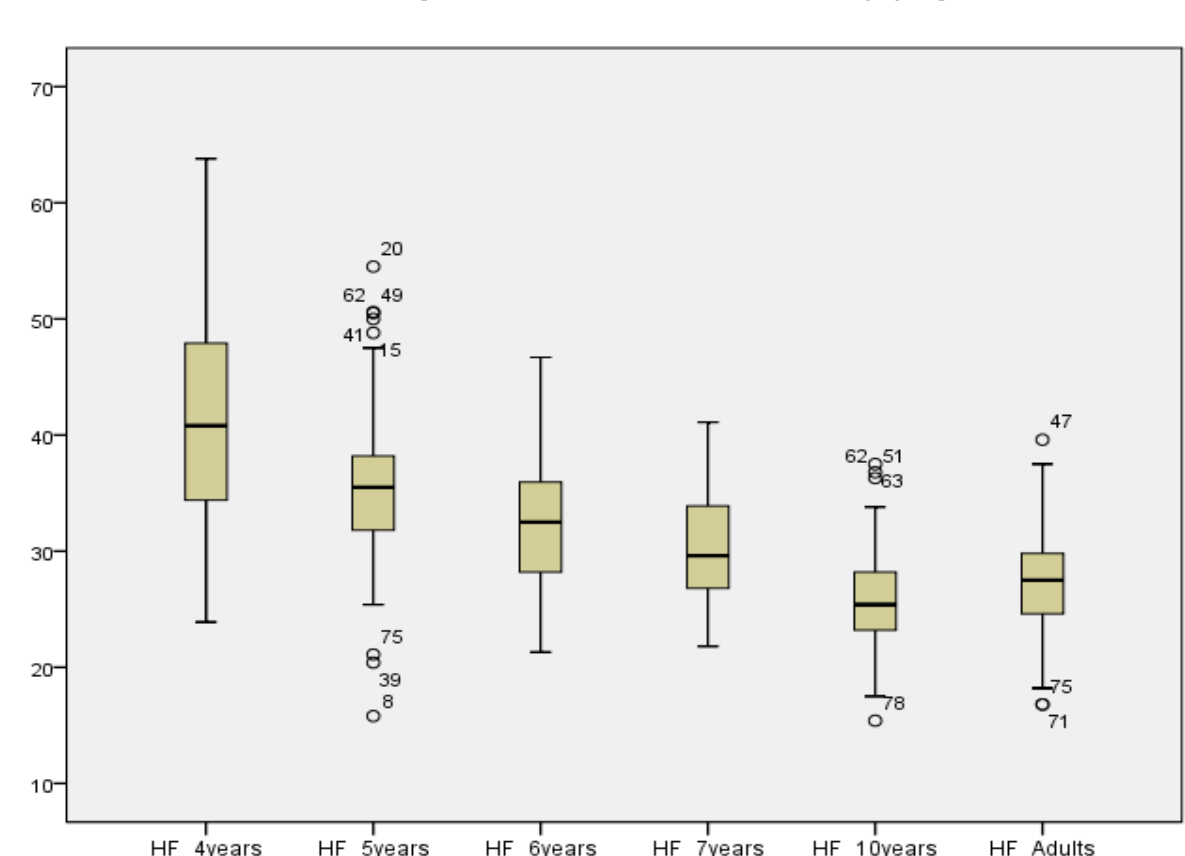
Figure 10. Age-related norm values in AAST in quiet across languages in comparison to the Maltese version. N.B. (Threshold plotted in y axis is the mean subtracted by 20dB; for example, in 6-year-old children, the average threshold is 25.3 dB SPL, and after correction with 20 dB, the THR is 5.3 dB HL). 0 246 810 12